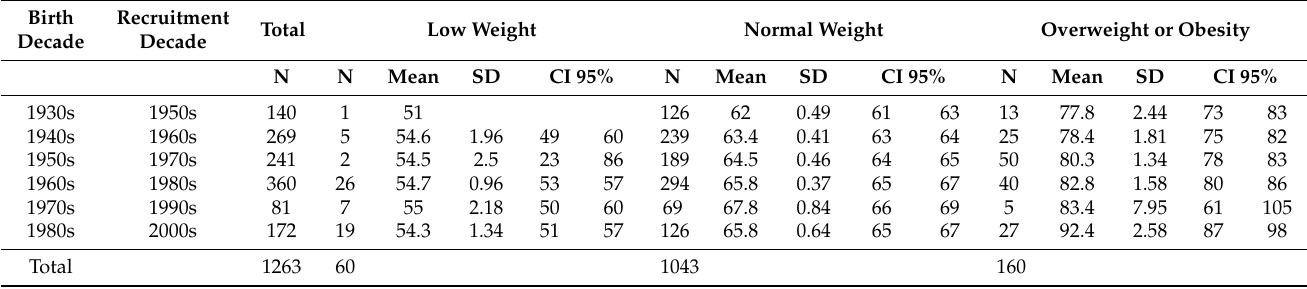
Figure 7. Annual average BMI (1955 – 2001) in SB. Trend line. Source: AMSB, ACDS. Own work.